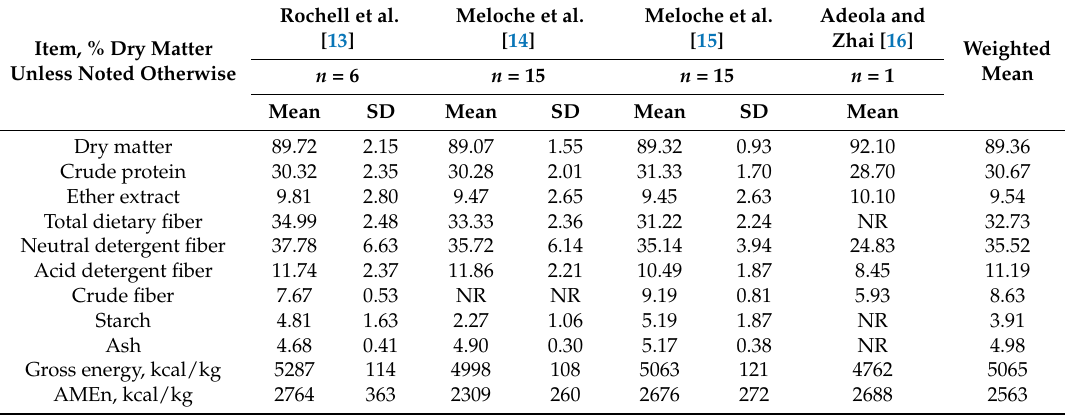
Abbreviation: SD = standard deviation, NR = not